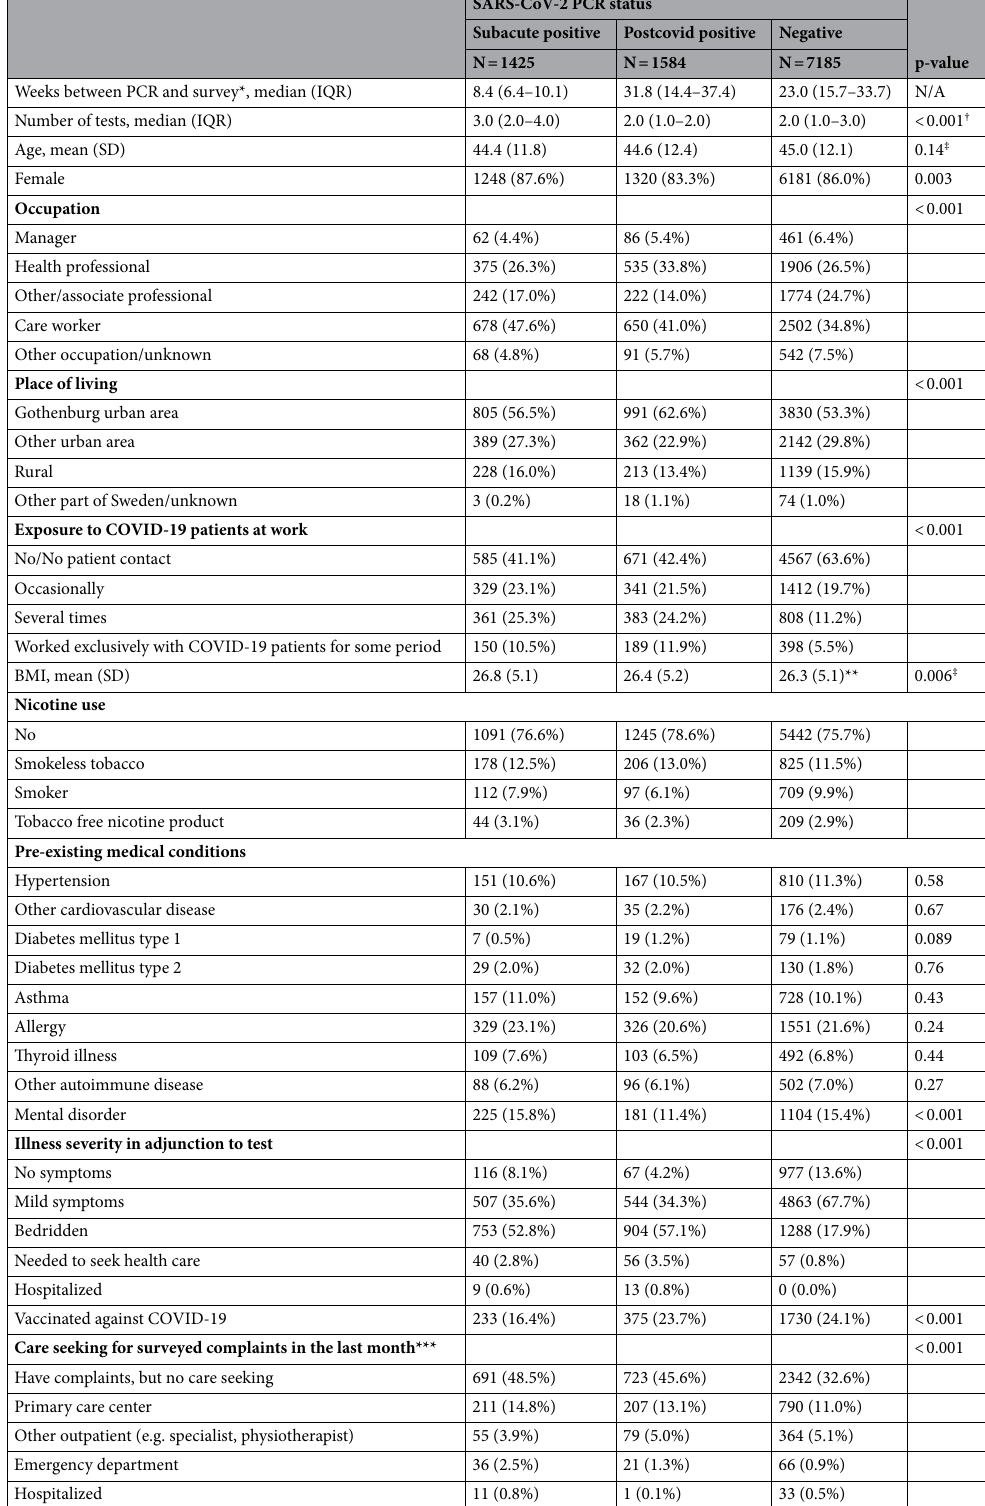
Table 1. Characteristics of the sample according to SARS-CoV-2 PCR status. Numbers are N (%) unless otherwise indicated. IQR interquartile range, SD standard deviation. P-values for categorical variables are from Pearson’s Chi-square tests, and from Kruskall–Wallis tests ( † ) or ANOVA ( ‡ ) for continuous variables. *Weeks from first positive test for those ever tested positive. Weeks from first negative test for those never tested positive. **BMI data was missing for four persons in this group. ***For each participant, only highest level of care is